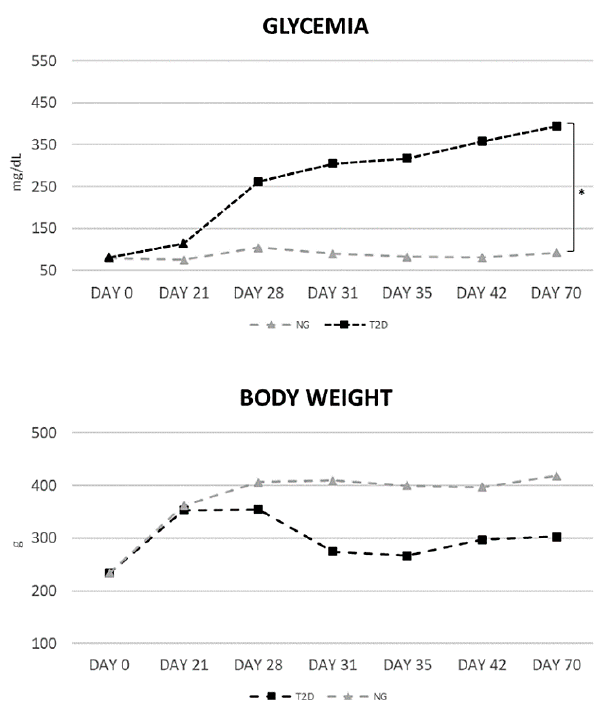
Figure 2. Graphs of Glycemia and Body Weight averages at beginning of diet, three weeks of diet, diabetes confirmation/dental extraction and euthanasia. Glycemia: Graph of the glycemic index monitoring over the days. Type 2 diabetic animals have a higher glycemic index, with statistically significant difference when compared to the normoglycemic group. Body Weight: Graph of the body weight monitoring over the days. Type 2 diabetic animals have a weight decrease, with no statistically significant difference when compared to the normoglycemic group. Symbols: * p < 0.05.